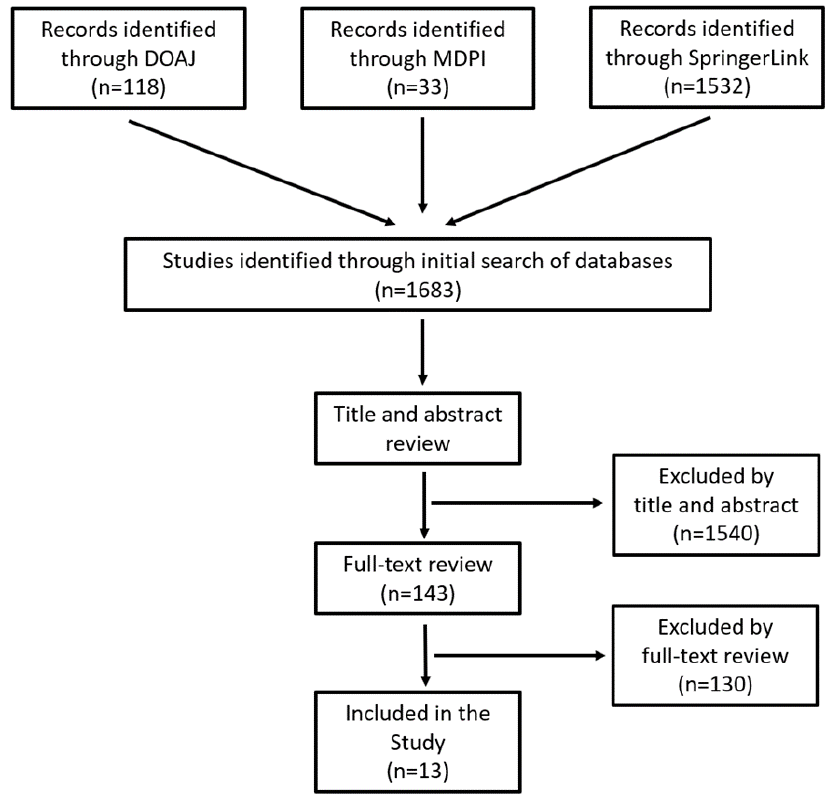
Figure 1. Summary of article selection process.